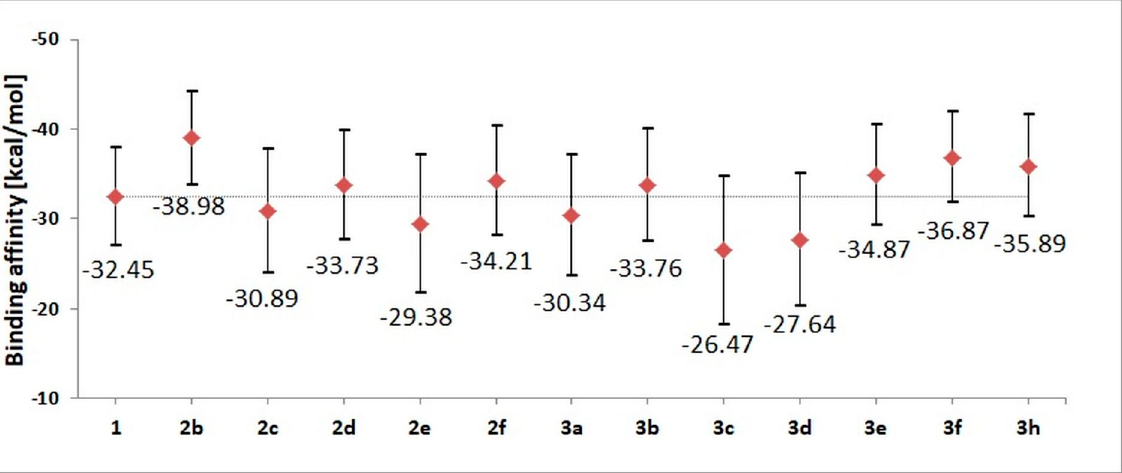
Figure 5. The values of binding enthalpy (kcal/mol) estimated for all complexes considered during molecular dynamics stage.